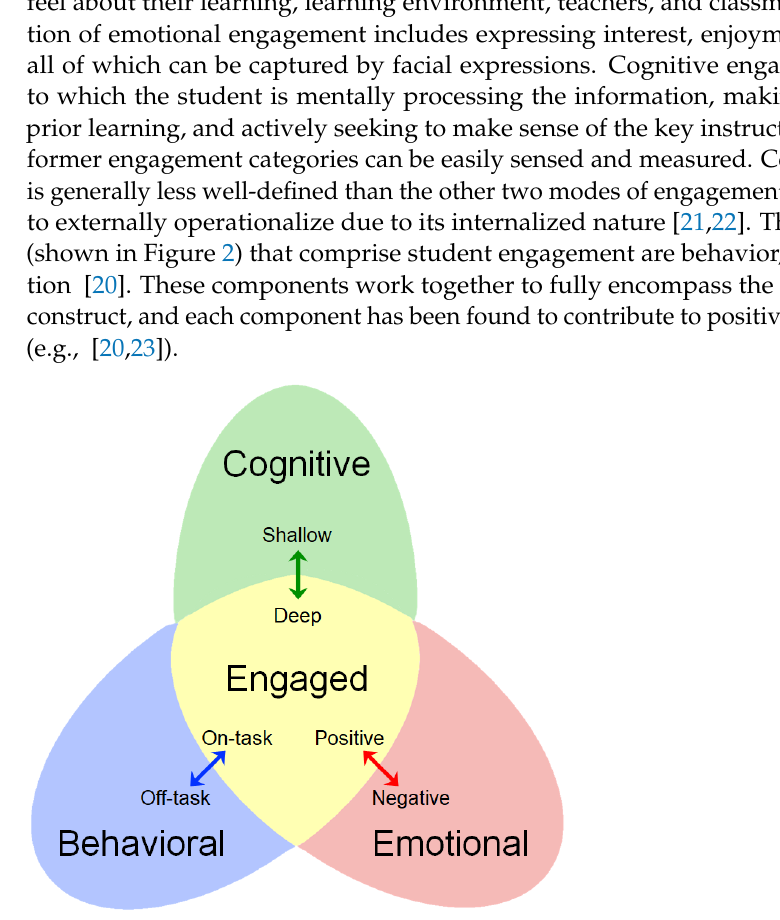
Figure 2. A conceptual framework linking on-task/off-task behavioral, positive/negative emotions, and deep/shallow cognitive